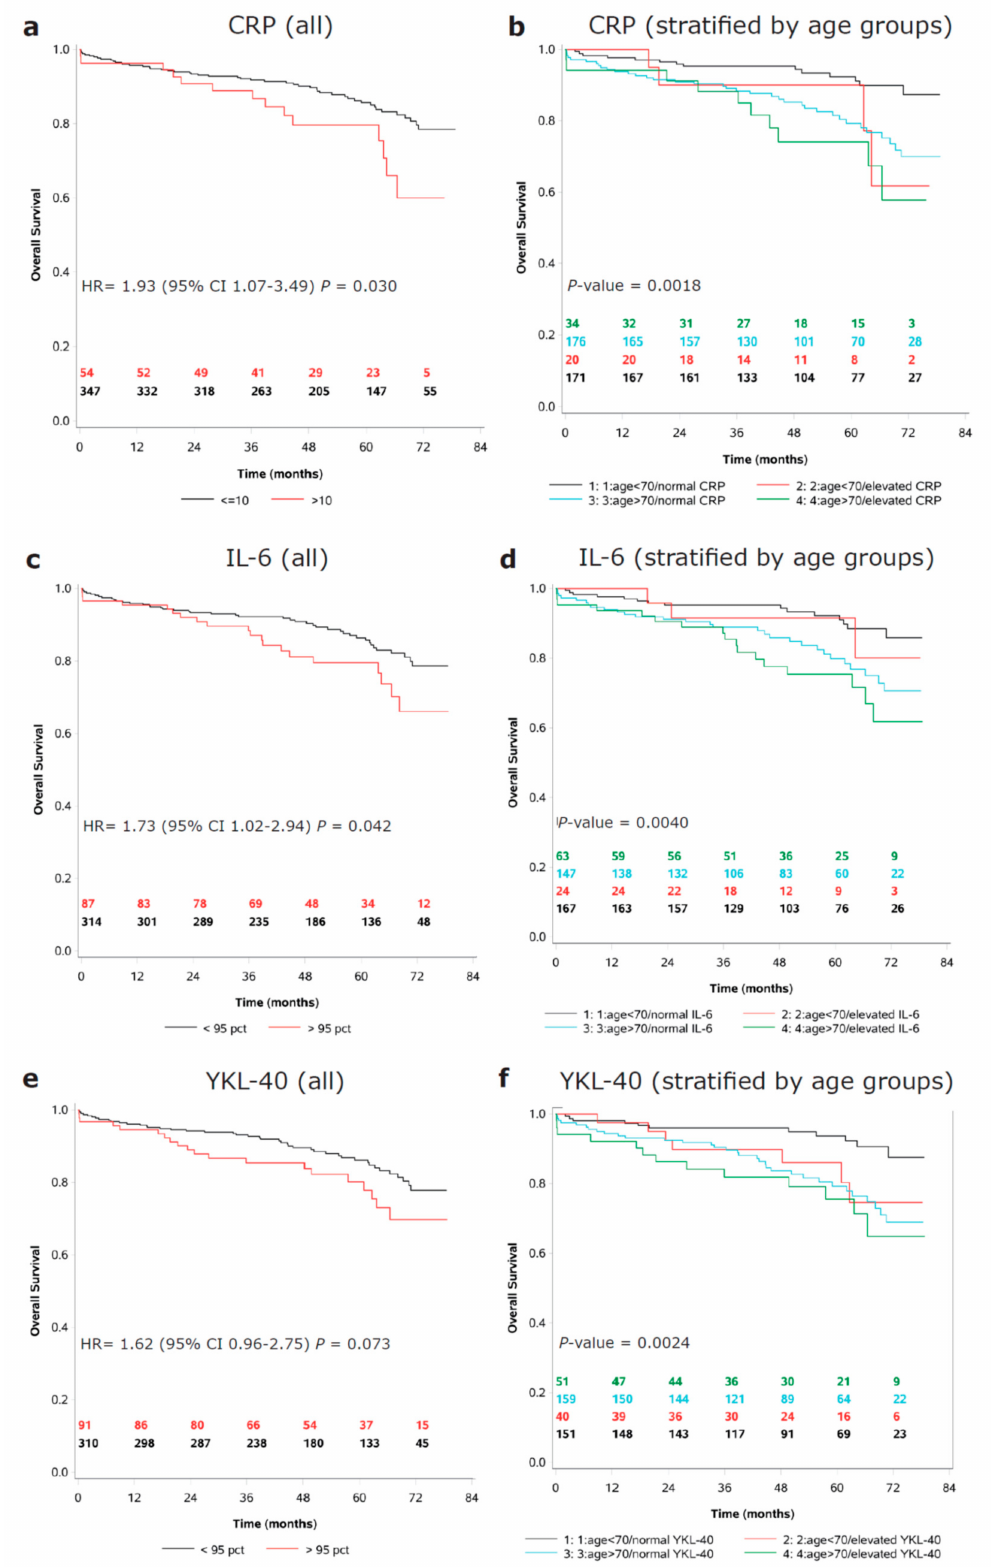
Figure 4. Kaplan–Meier plots showing preoperative dichotomized biomarker (normal/high) associa- tions with overall survival. ( a ) CRP. ( b ) CRP stratified by age groups. ( c ) IL-6. ( d ) IL-6 stratified by age groups. ( e ) YKL-40. ( f ) YKL-40 stratified by age groups. Abbreviations: CRP, C-reactive protein; HR, hazard ratio; and IL-6,